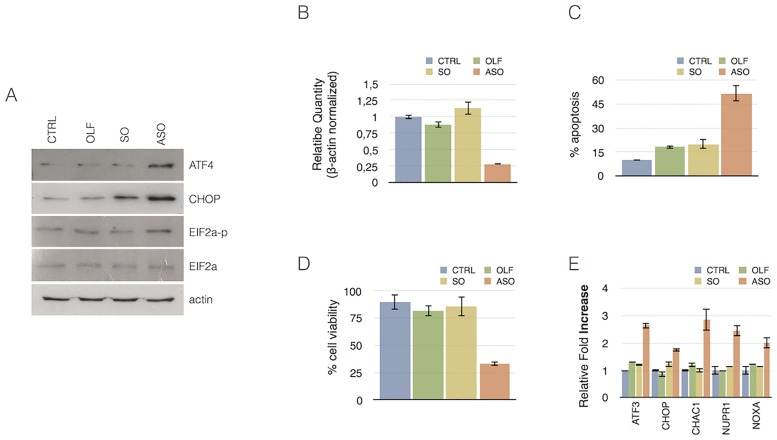
Western blotting demonstrating the significant increase of ATF4, CHOP and EIF2a-p after CSB knockdown.B) Graphs showing qRT-PCR analysis of CSB mRNA expression in SKNBE-2c cells, at 12h after the transfection. The results, normalized to β-actin, were averaged from values obtained by performing three technical replicates. The values are means ± SD. Graphs showing apoptosis (C) and cell viability (D) percentage in SKNBE-2c cells 48h after CSB ablation. The results were averaged from values obtained by performing three technical replicates. The values are means ± SD. E) Graphs show relative fold change values of up-regulation of selected genes in SKNBE-2c cells. The results, normalized to β-actin, were averaged from values obtained by performing three technical replicates. The values are means ± SD.